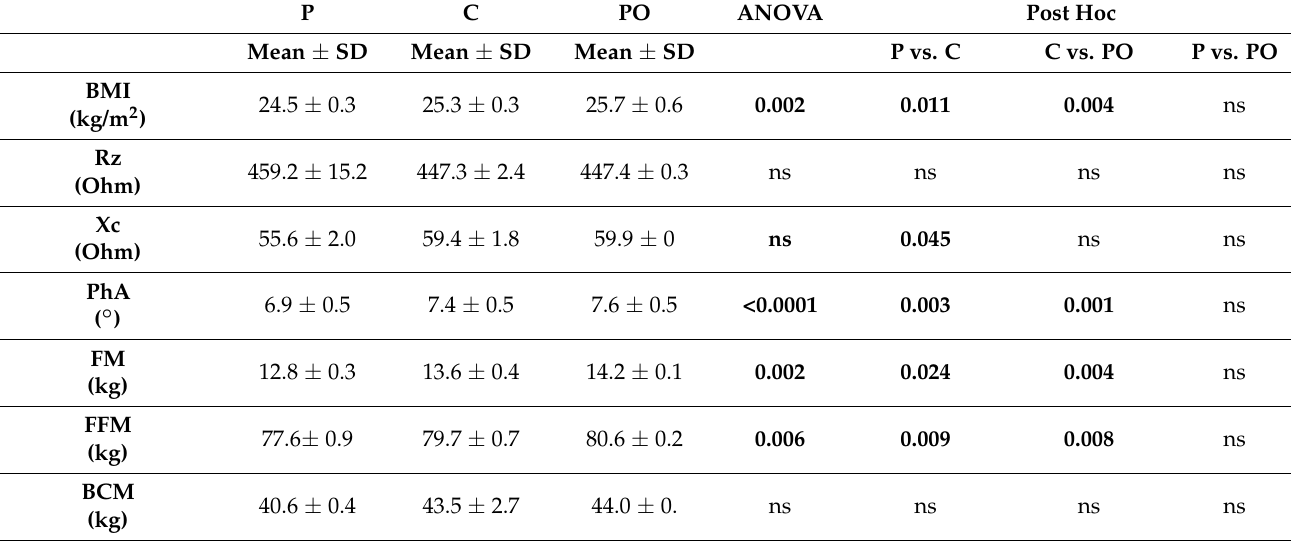
Table 2. Anthropometric, bioelectrical parameters and MEDAS score referring to “Key times” selected from the entire study period in total